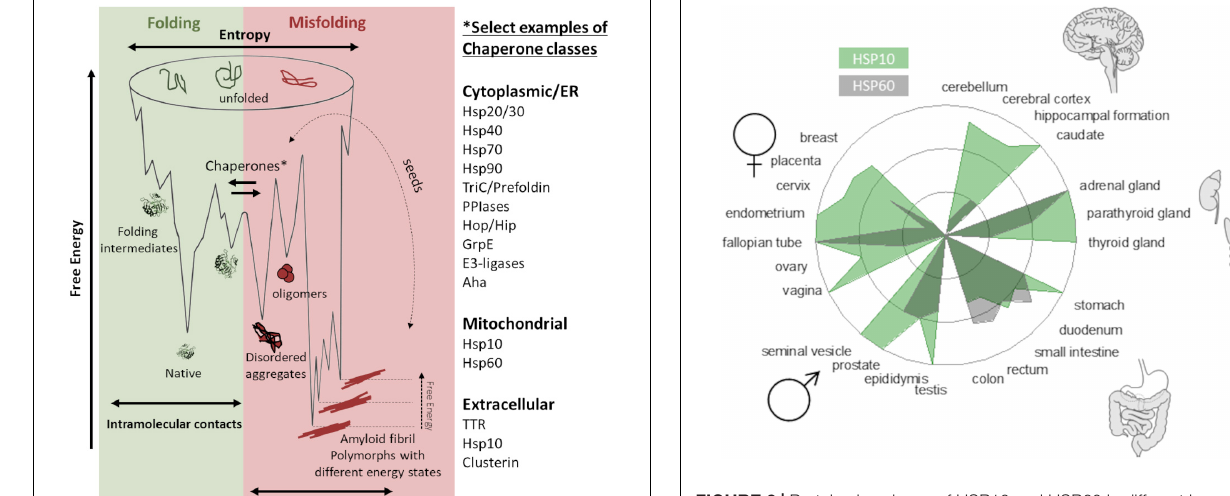
FIGURE 2 | Protein abundance of HSP10 and HSP60 in different human tissues from the Human Protein Atlas (www.proteinatlas.org). The radar plot depicts levels from high to non-detectable. HSP10 is denoted in green and HSP60 is denoted in gray. Note that the abundance of HSP10 is very high in brain tissue implicating the importance of HSP10 for neurodegenerative